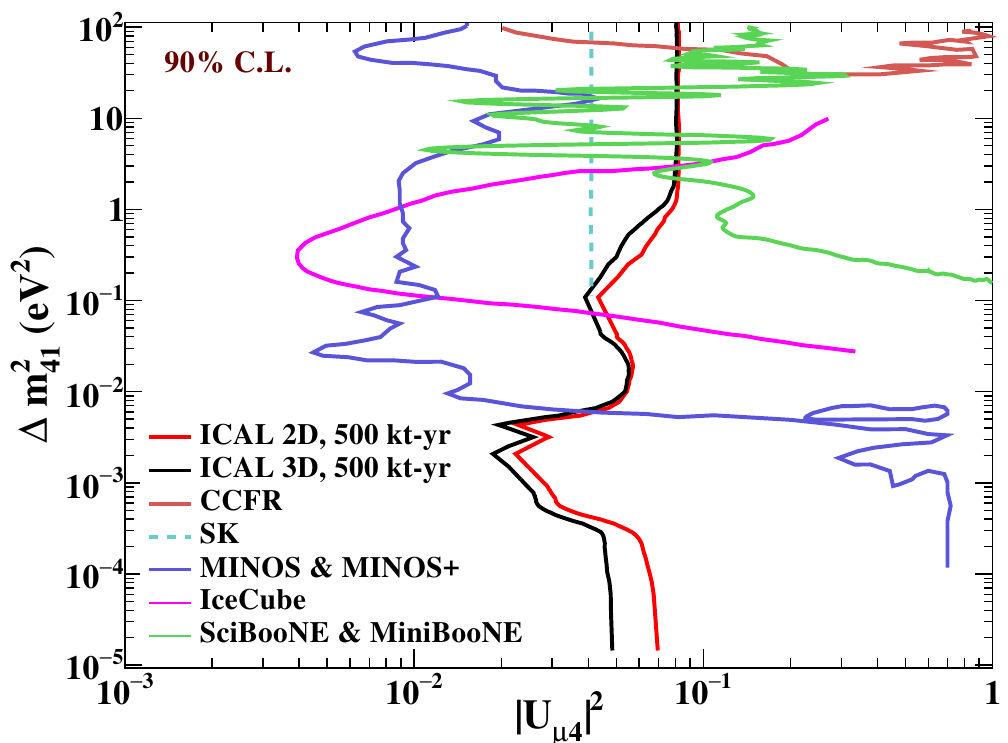
Figure 9 . Comparison of the 90% exclusion contours for INO-ICAL in the N-N mass order- ing scheme with an exposure of 500 kt-yr, with the current constraints from other experiments: CCFR [44], Super-Kamiokande (SK) [49], IceCube [50], MINOS and MINOS+ [127], SciBooNE and MiniBooNE [47]. The Super-Kamiokande contour, shown with a dotted line, is the result of the analysis using a one-parameter (cid:12)t, while all the other contours are with analyses using two- parameter